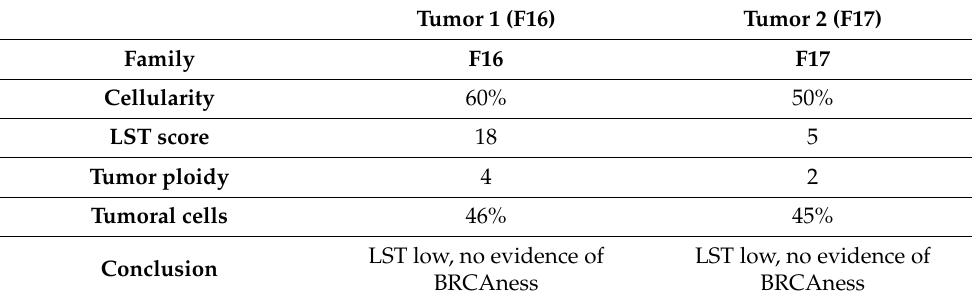
Table 3. Tumor analysis and LST.